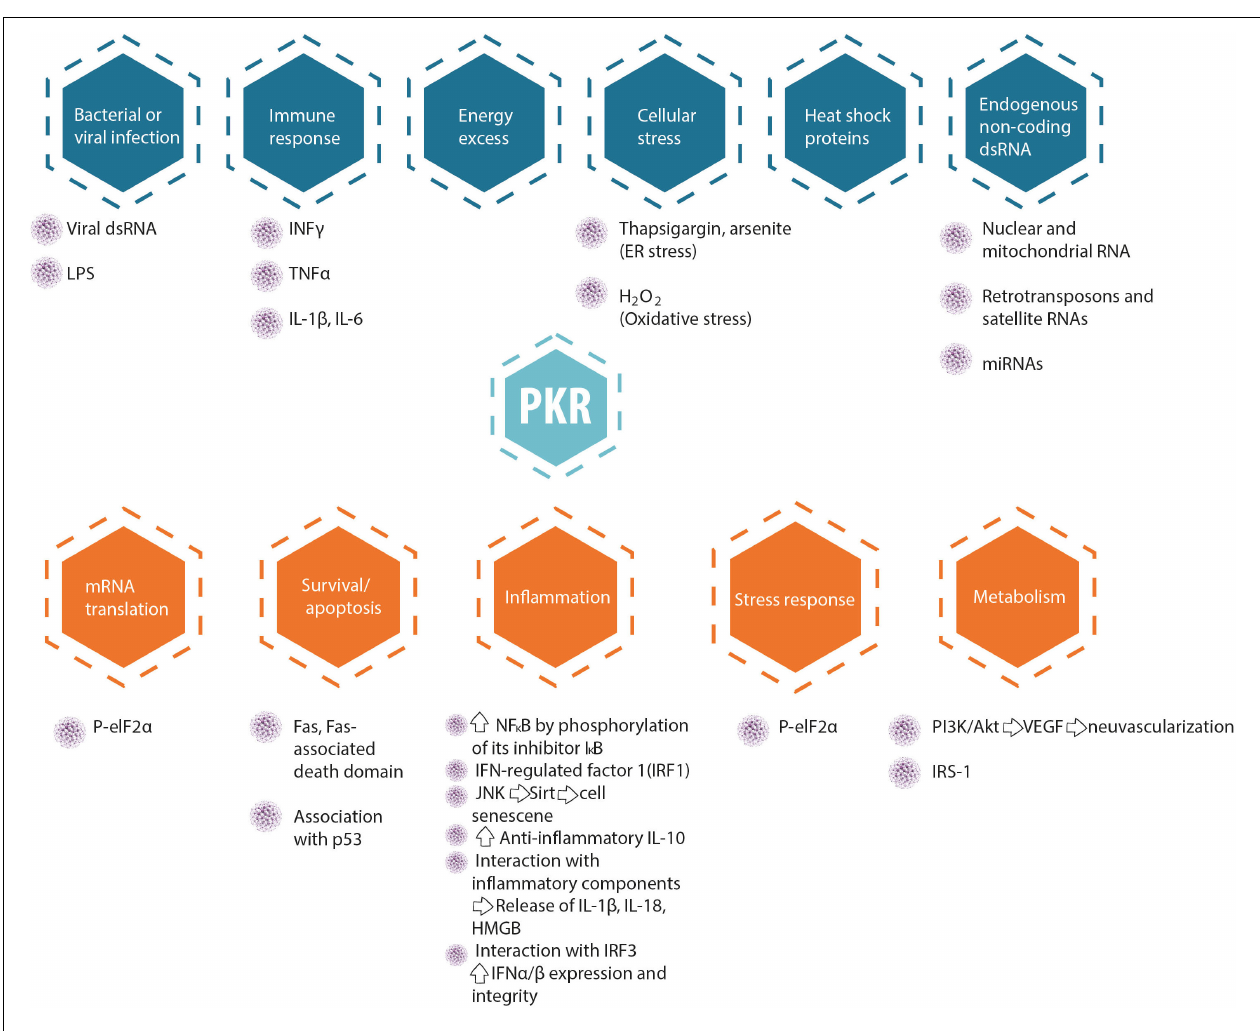
FIGURE 2 | Upstream regulators and downstream targets of